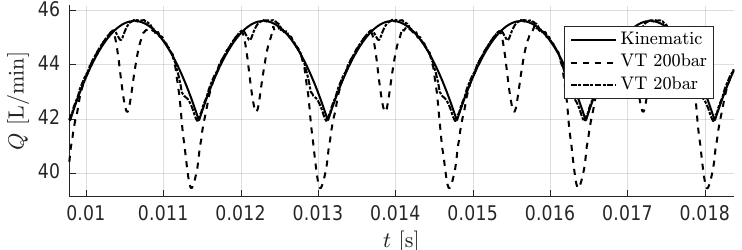
Figure 6. Flow-ripple compared to the kinematic flow at 200 bar and 20 bar (simulated based on the reference EGP with 2000 RPM and VT circuit).